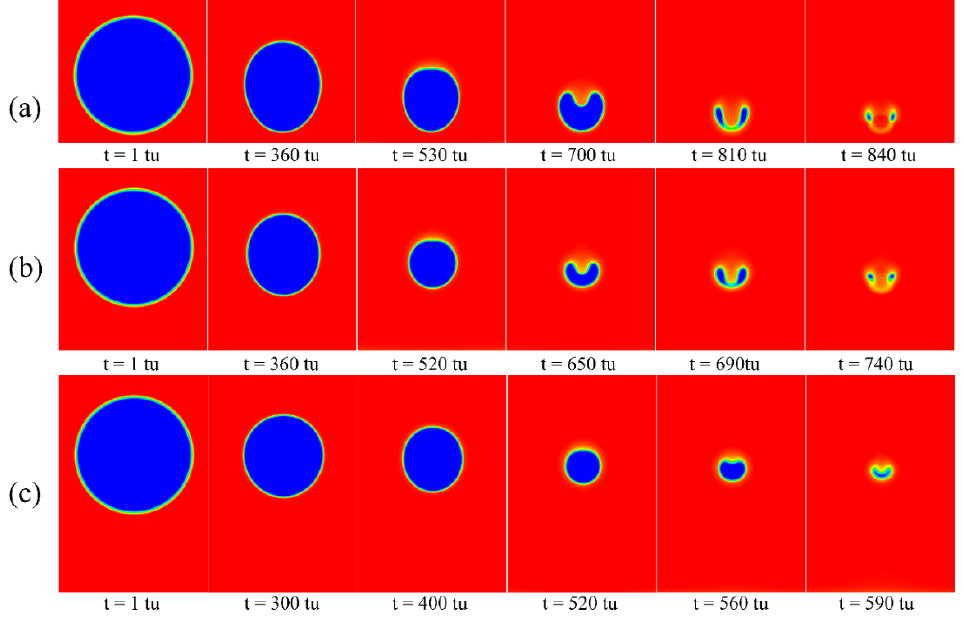
Figure 6. Cavitation bubble collapse in different positions by DDF-LBM model. ( a ) λ = 1.2; ( b ) λ = 1.8; ( c ) λ = 2.4.